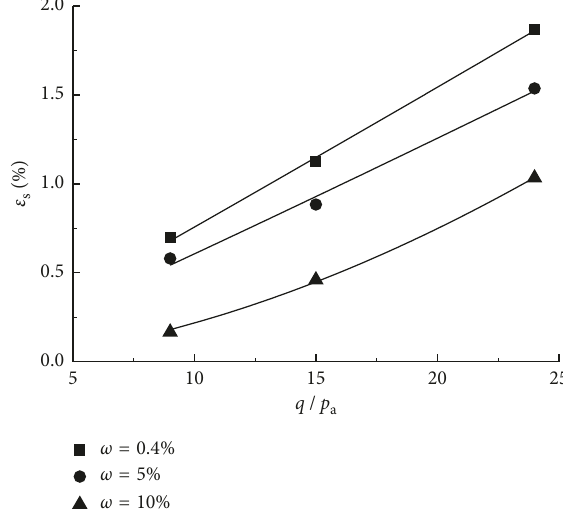
Figure 12: q / p a versus ε s curve (different initial water content conditions).